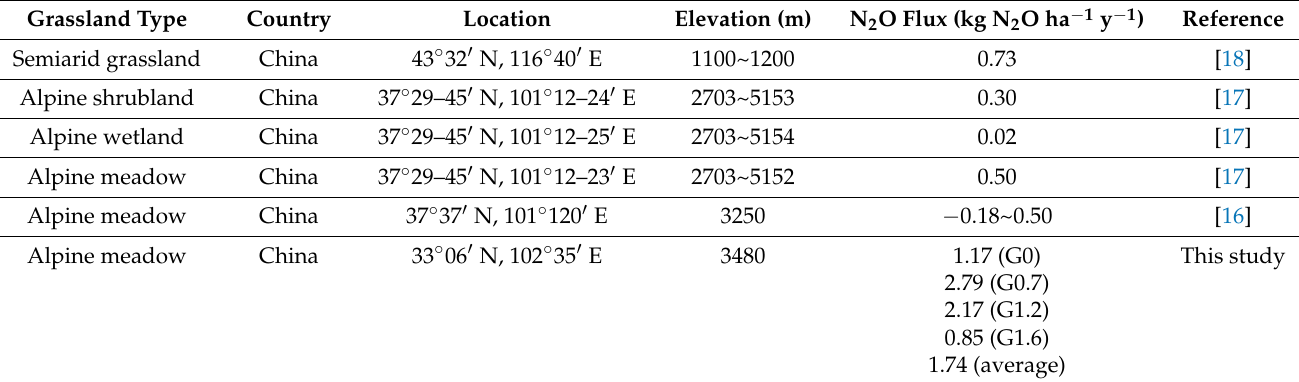
Table 3. Comparisons of annual mean N 2 O fluxes with other studies in different grassland